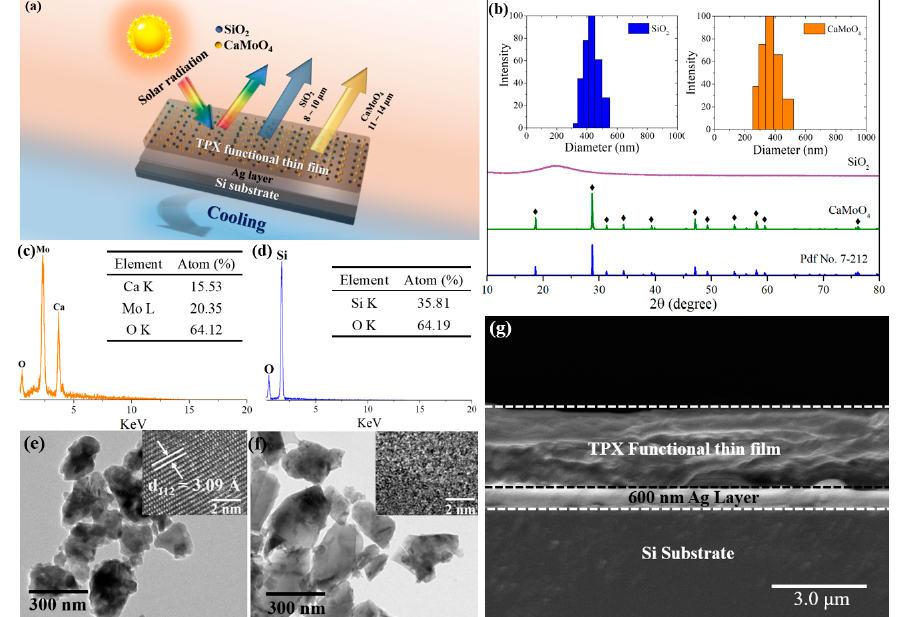
Figure 2. ( a ) Schematic drawing of the bilayer selective emitter. ( b ) X-ray diffraction patterns of the CaMoO 4 and SiO 2 nanoparticles. Insets are the particle size distribution of the nanoparticles. ( c , d ) Energy dispersive spectrometer (EDS) patterns of ( c ) CaMoO 4 and ( d ) SiO 2 nanoparticles. ( e , f ) TEM imagines of ( e ) CaMoO 4 , and ( f ) SiO 2 nanoparticles. ( g ) SEM images of the section morphology of the emitter.